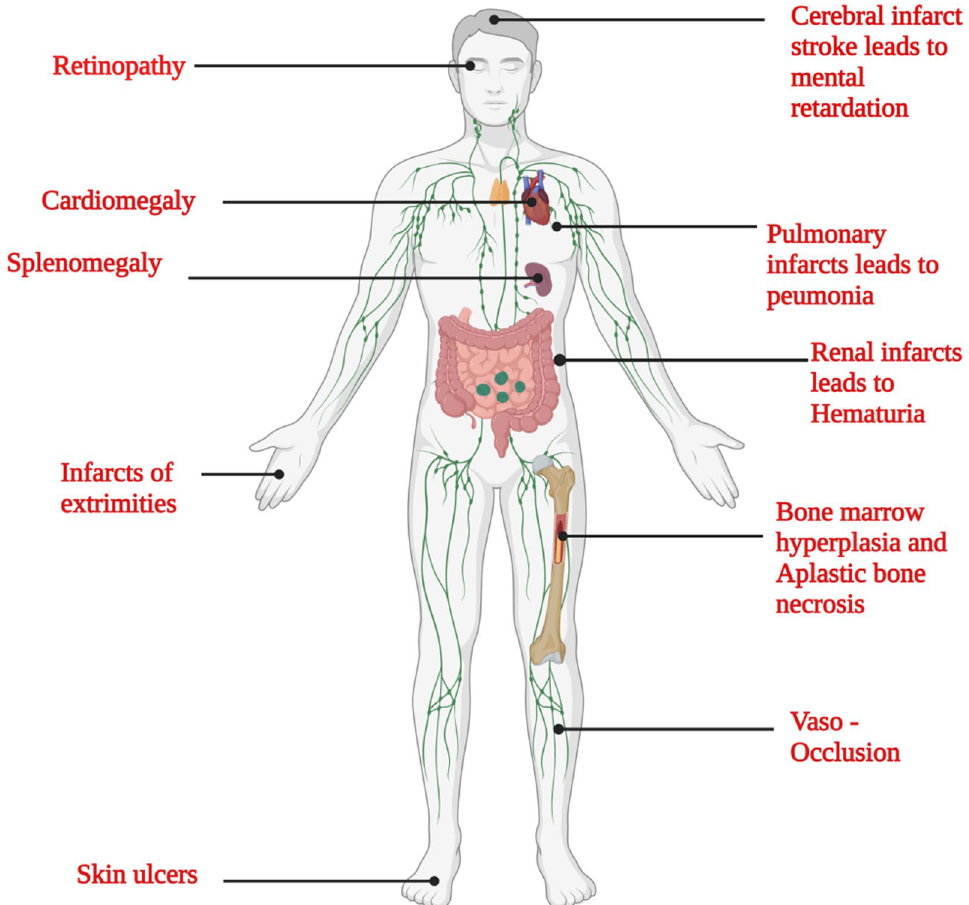
Fig. 4 Complications associated with SCD (Created with